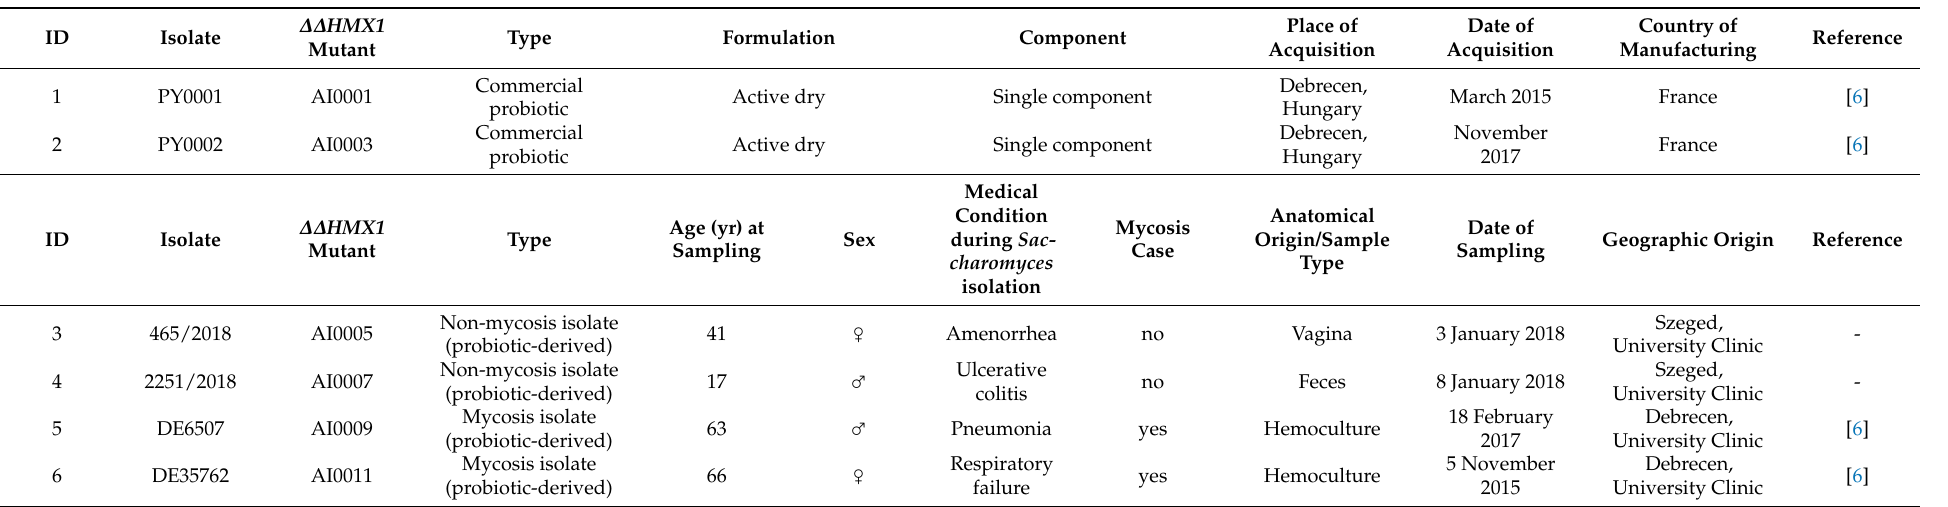
Table 1. Commercial and clinical isolates, and their corresponding ∆∆ HMX1 mutant strains used in this